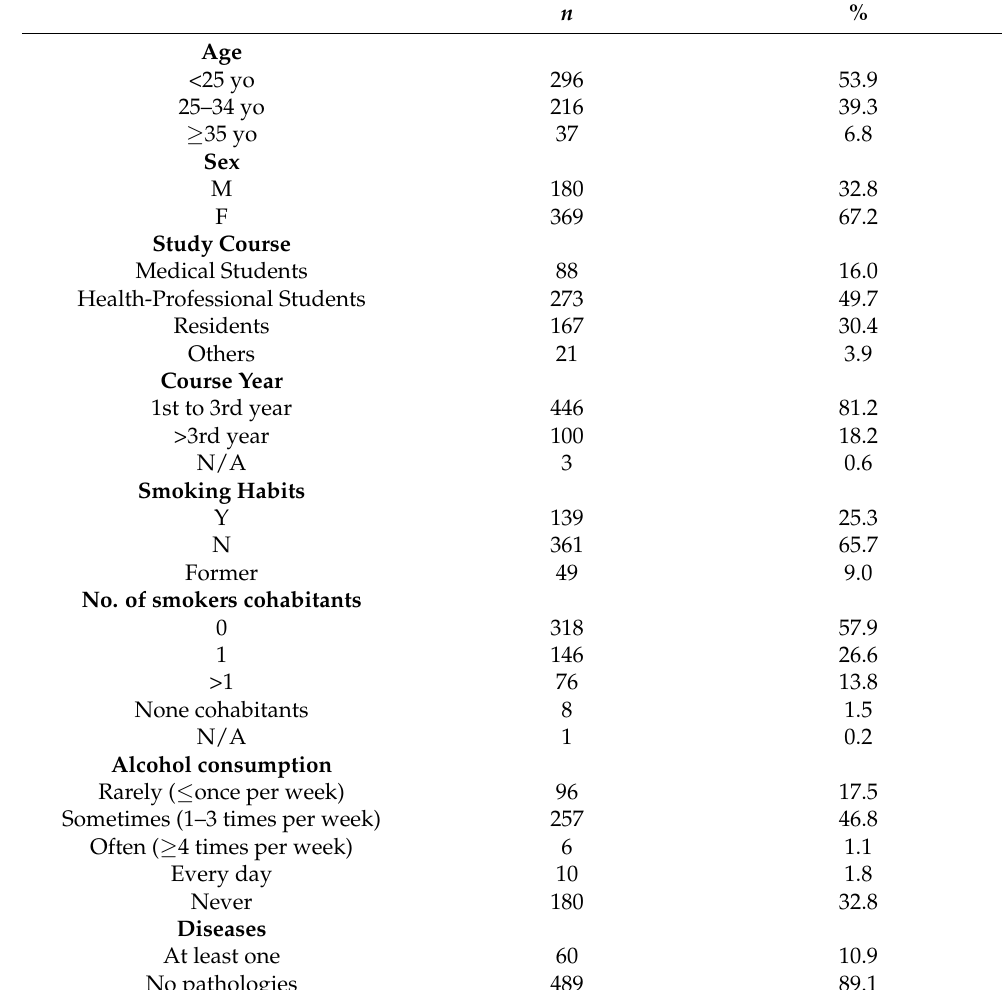
Table 1. Main socio-demographic and anamnestic characteristics of the